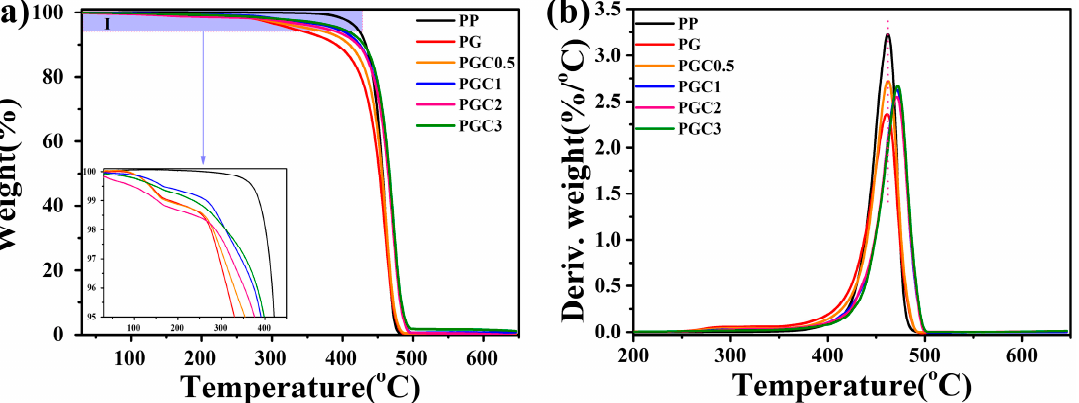
Figure 4. TGA ( a ) and DTG ( b ) curves of PP and the PP/DCP/GMA/C blends with different tea polyphenols (C) loading. The inserted figure at the bottom of ( a ) shows the enlarged I region, which illustrates the initial degradation of the